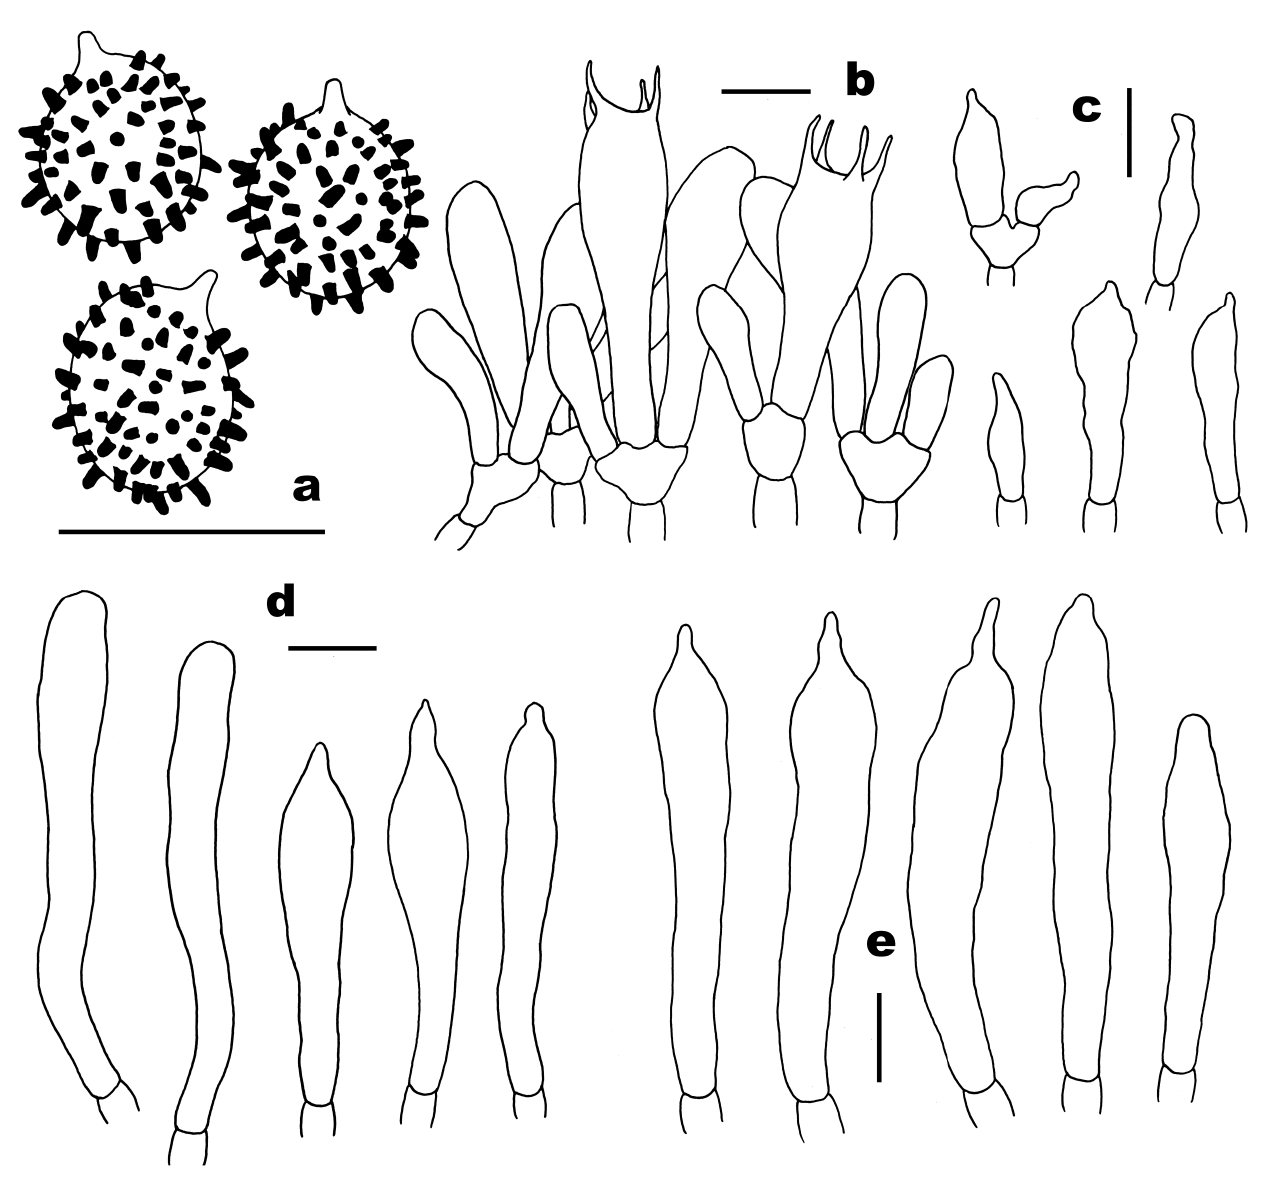
Figure 6. Microscopic features of Russula oraria (FHMU5355, holotype). ( a ) Basidiospores. ( b ) Basidia and basidiola. ( c ) Marginal cells. ( d ) Pleurocystidia. ( e ) Cheilocystidia. Bars: 10 μm. Drawings by Y.X. Han.